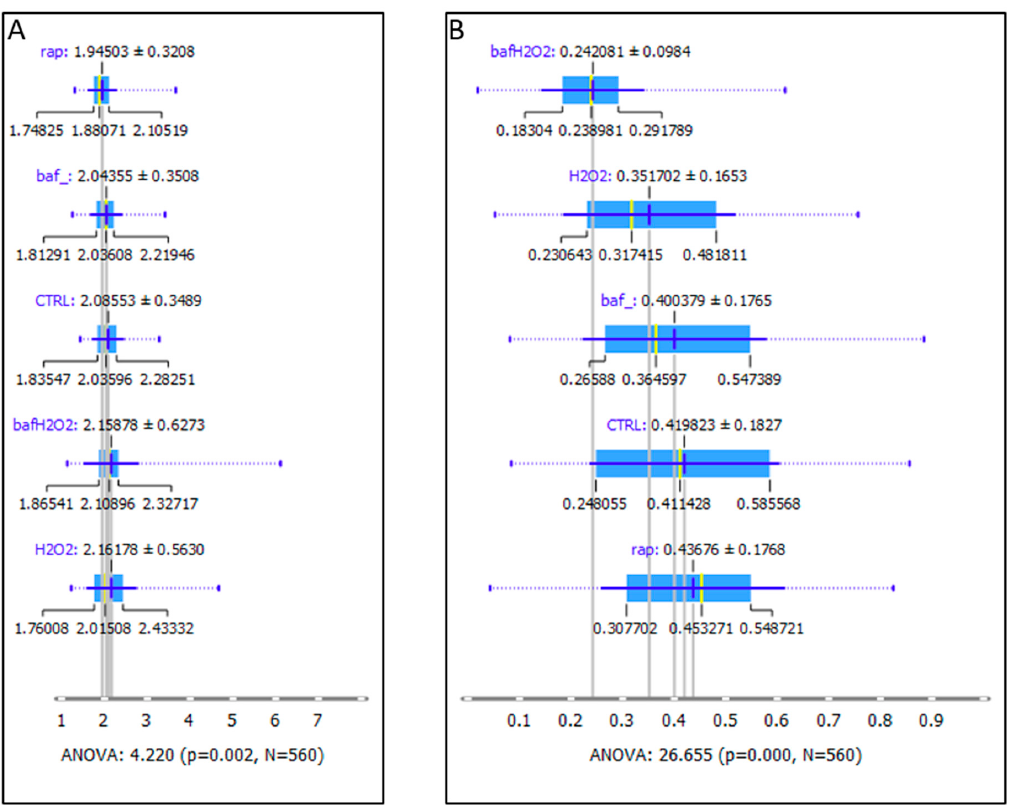
Figure 4. Analysis of ( A ) oxidative stress markers—the ratio of CH 2 and CH 3 asymmetric vibration bands are shown, as well as ( B ) the presence of C=O groups. Values are presented as mean±SD.